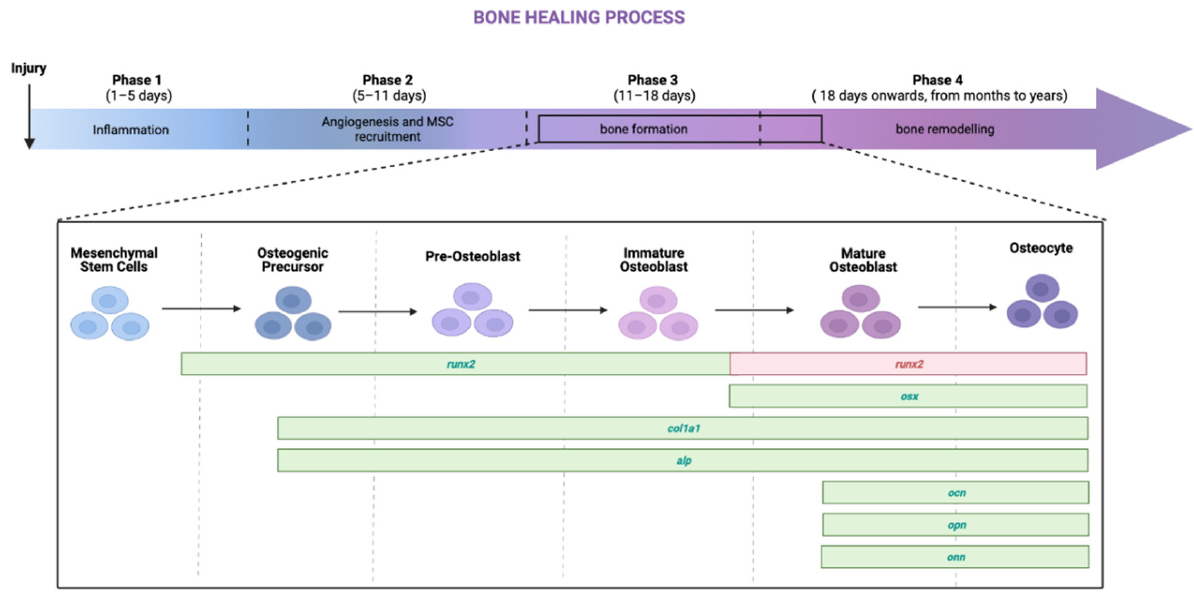
Figure 1. Schematic representation of bone healing process focused on bone formation and part of bone remodeling phases. Runt-related transcription factor (RUNX 2 ) is early expressed during bone formation, keeping the osteoblasts in immature state; successively, the simultaneous down-regulation of RUNX2 and the up-regulation of osterix (OSX) allows osteoblasts’ maturation. The activating transcription factor 4 (ATF 4 ) regulates osteoblast differentiation, working in cooperation with OSX, promoting bone matrix protein synthesis such as osteocalcin (OCN), which has the ability to bind calcium to modulate the calcium metabolism by mediating its association with hydroxyapatite (HA) [9]; osteopontin (OPN) regulates osteoclast genesis and osteoclast activity, contributing to bone formation and resorption [10,11]; and osteonectin (ONN) is a regulator of the calcium release by binding collagen and HA crystals, thereby influencing the mineralization of collagen during bone formation [12]. Collagen α -1 type I